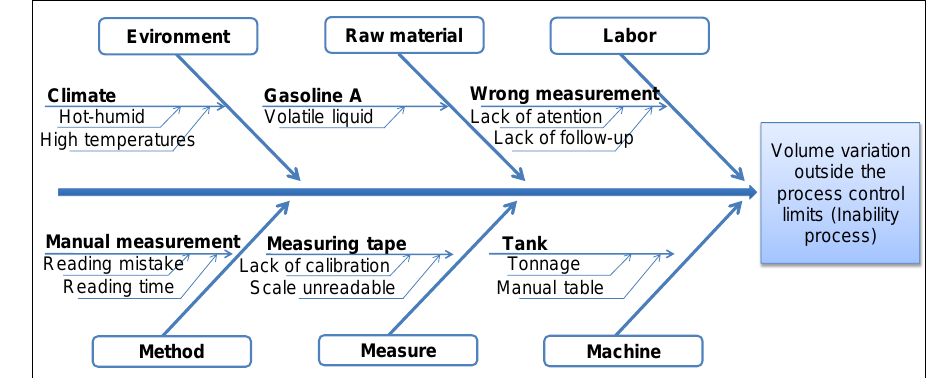
Figure 7: Ishikawa Diagram (cause-efectt) for volume